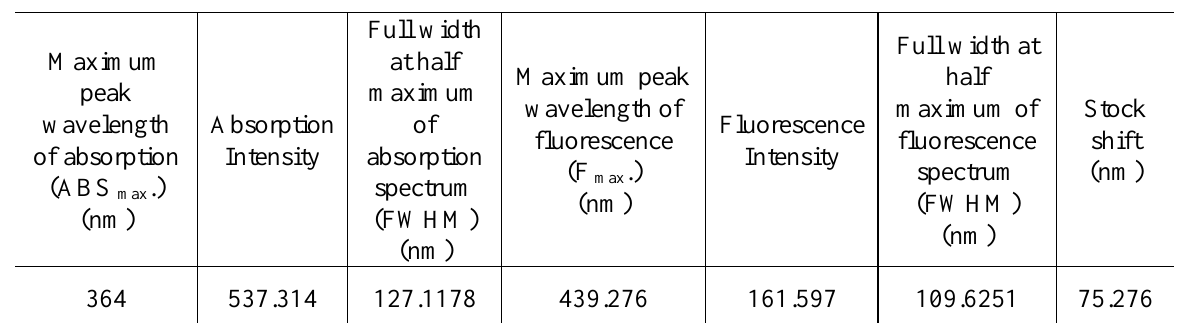
Table 1: The (absorption, fluorescence) wavelength at relative maximum intensity;full width at half maximum (FWHM) and stock shift of Vitamin D